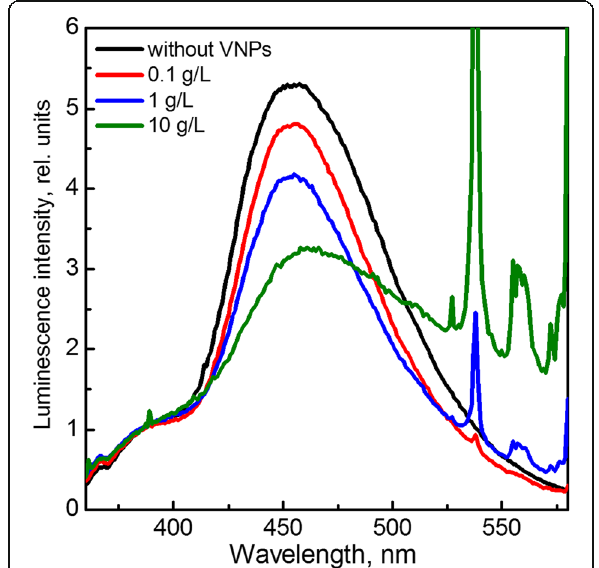
Fig. 4 Normalized fluorescence spectra of coumarin water solution containing different concentration of VNP recorded after 30 min X-ray irradiation